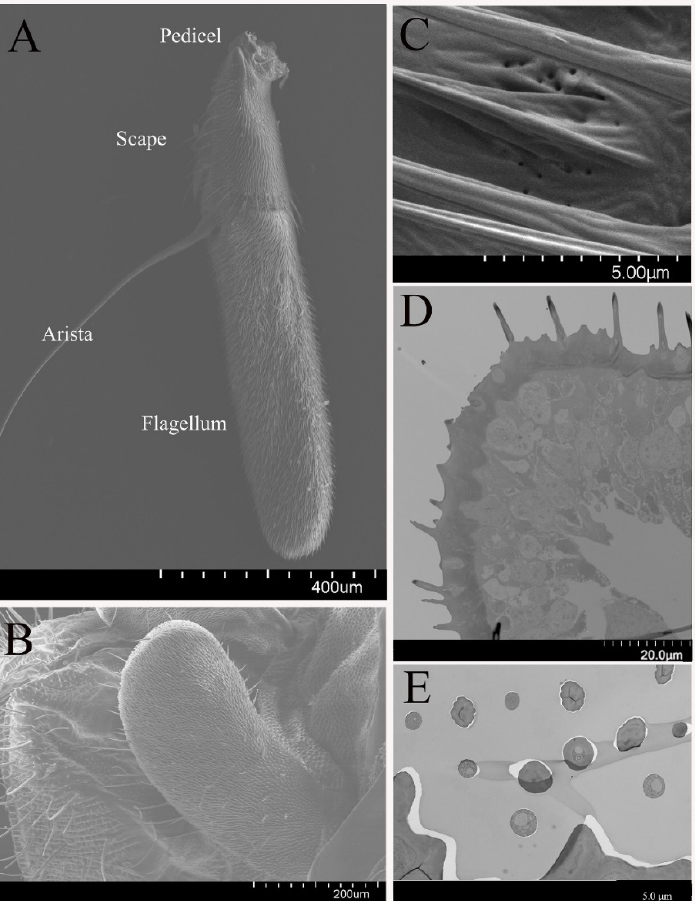
Figure 1. Morphology of B. dorsalis antenna and maxillary palps. ( A ) Numerous sensilla distributed on female B. dorsalis antenna, including the scape, pedicel, funiculus, and arista. The distribution on male antenna is similar to the female. ( B ) Numerous sensilla on male B. dorsalis maxillary palp. The sensilla distribution on female maxillary palp is similar to the male. ( C ) Pores on the pedicel surface near the sensilla chaetica. ( D ) Cross-sections at the base and the tip ( E ) of the antennae show the distribution of various sensillum types. Table 1. Abundance and distribution of sensilla on B. dorsalis antennae and maxillary palps. Antenna Maxillary palps Scape Pedicel Flagellum Sex